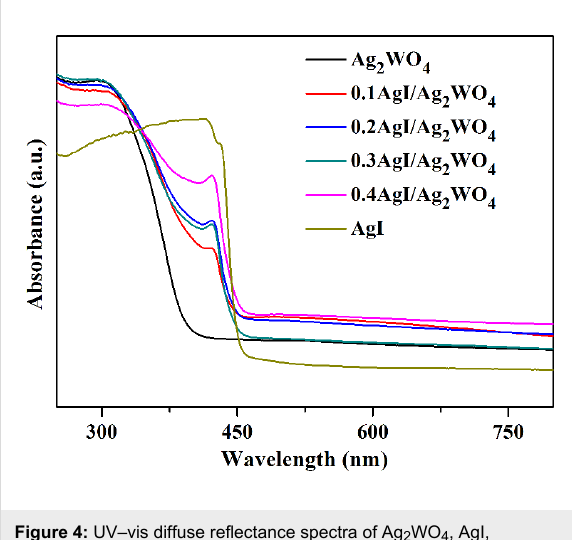
Figure 4: UV–vis diffuse reflectance spectra of Ag 2 WO 4 , AgI, 0.1AgI/Ag 2 WO 4 , 0.2AgI/Ag 2 WO 4 , 0.3AgI/Ag 2 WO 4 , and 0.4AgI/Ag 2 WO 4 .